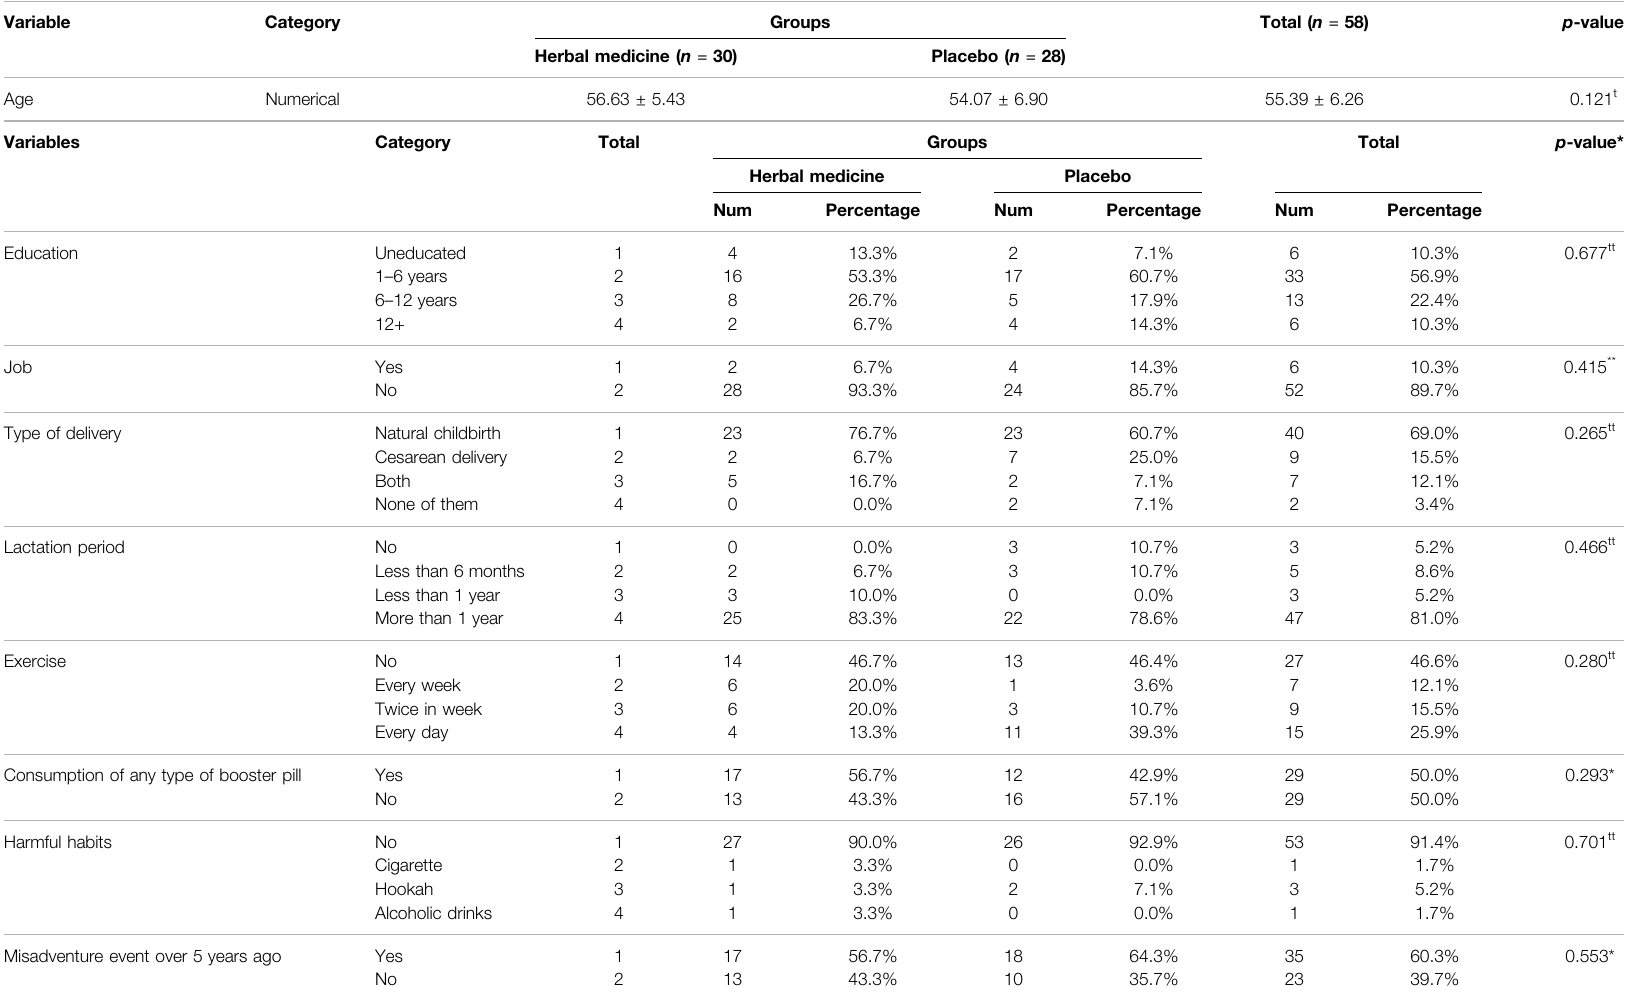
TABLE 2 | Comparison of the baseline characteristics of participants between two study